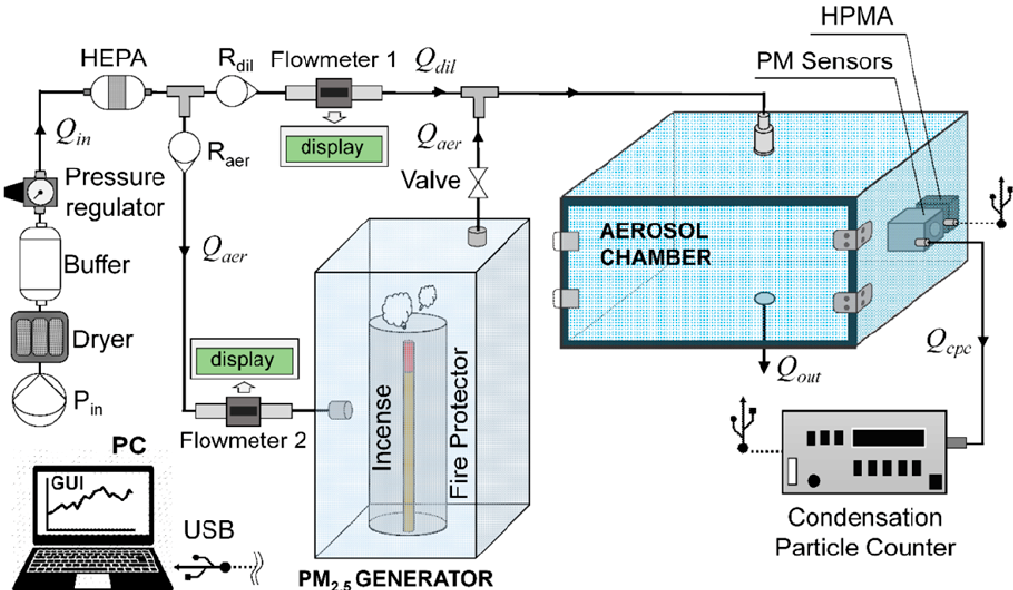
Figure 11. Experimental setup to characterize the aerosol chamber and evaluate the PM sensors of Hapidin (2019) (image reprinted under the terms of the Taiwan Association for Aerosol Research and Aerosol and Air Quality Research. All articles published on this site use the Creative Commons Attribution 4.0 License (CC BY 4.0); Aerosol and Air Quality Research, 19: 181–194, 2019; doi:10.4209/aaqr.2017.12.0611).